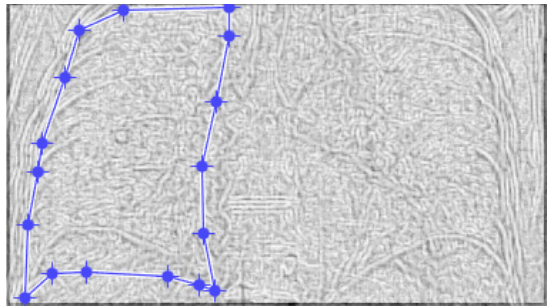
Figure 24. De fi ning the mask for the left lung of the fi fth patient.